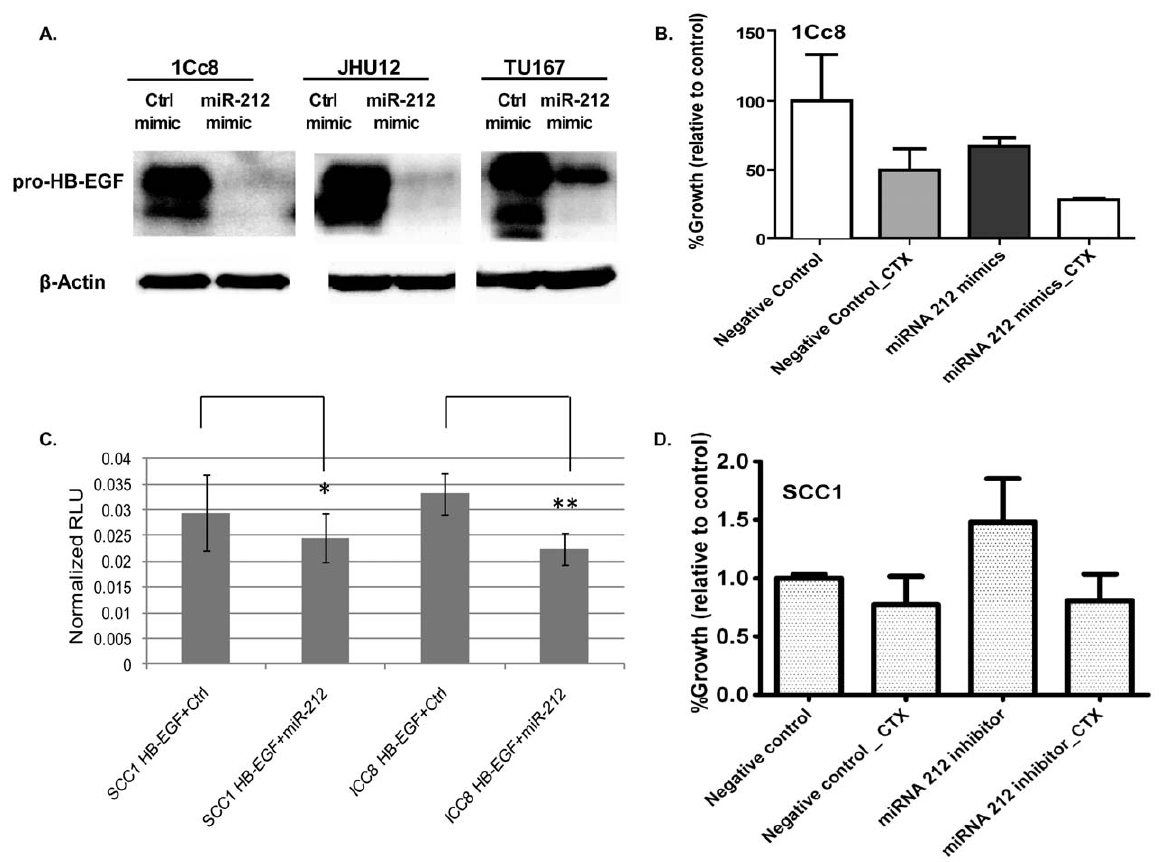
Figure 5. MicroRNA-212 regulates HB-EGF expression in cetuximab resistant cells. A) Pro-HB-EGF expression following the transfection with miR-212 mimics in three cetuximab resistant cell lines. B) Growth inhibition rate of 1Cc8 cells with exogenous miR-212 mimics, cetuximab or a combination of miR-212 mimics and cetuximab measured by colony formation assay. C) MicroRNA-212 directly regulates HB-EGF by binding to the 3 9 untranslated region of HB-EGF in cetuximab resistant 1Cc8 cells while it was not significant in cetuximab sensitive SCC1 cells (*, p=0.47; **, p=0.038). RLU – Raw Light Units. D) Growth rate comparison of SCC1 cells in the presence of cetuximab, exogenous miR-212 inhibitor, or a combination of miR- 212 inhibitor and cetuximab measured by colony formation assay.